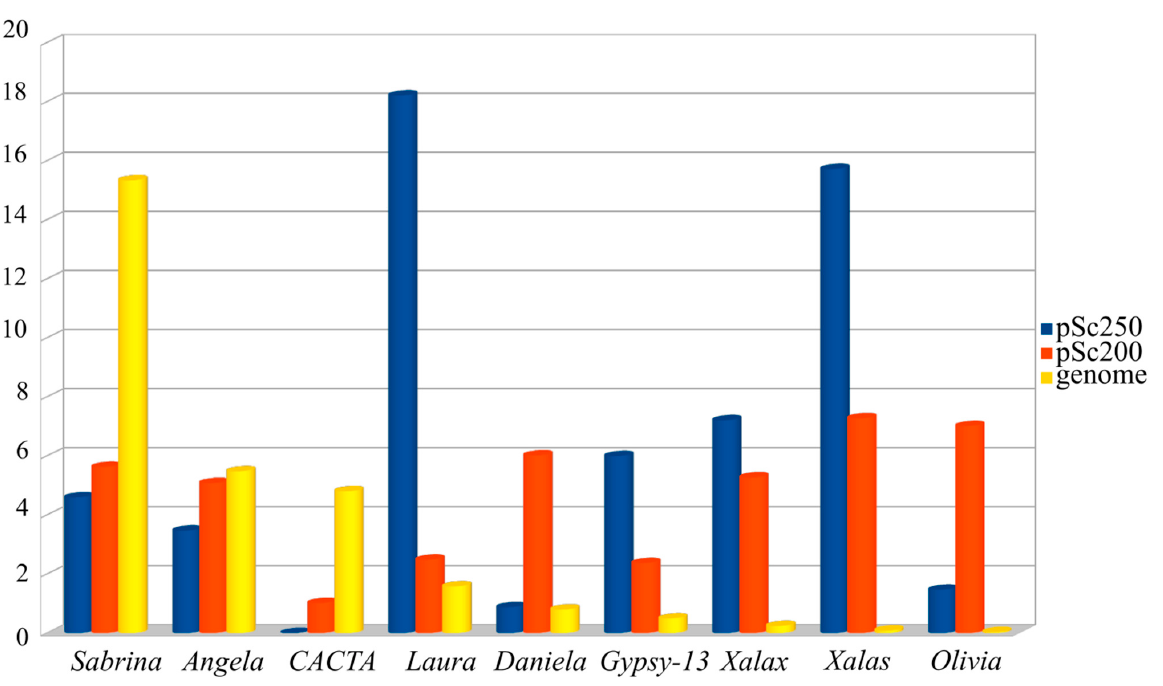
Figure 2. Presence of the most well-represented TE families in the rye genome ( Sabrina, Angela, CACTA , yellow bars) and in the reads containing regions of junctions between non-tandem DNA and the monomers of pSc200 tandem repeats ( Olivia, Daniela, Xalas, Xalax, red bars) and pSc250 tandem repeats ( Laura, Xalas, Xalax, Gypsy-13_TA-I , blue bars). Thus, a surprising feature revealed by comparing the abundance of the DNA se- quences in the entire rye genome and when these sequences were flanked by the arrays of the tandem monomers pSc200 and pSc250 was a nearly reciprocal replacement of TE families. In terms of genome-wide abundance, Sabrina , CACTA and WHAM yield prece- dence to Daniela and Olivia flanked by pSc200 and Laura and Gypsy -13_TA-I flanked by pSc250, but the abundance of solo-LTRs designated as Xalas or Xalax is just rocketing, especially when these are flanked by pSc250. As the ectopic exchange model suggests [42], this should be indicative of very frequent ectopic exchanges in the immediate neighborhood of the tandem arrays pSc200 and pSc250 while these arrays were in the making. The main sources of solo-LTRs are probably unequal cross-overs and the with- in-chromosome ectopic recombination between the LTRs of the same or different ele- ments, provided that they share quite extended homologous regions, such as those shared by Xalas and Xalax , and Daniela and Olivia . Vicient et al. [43] distinguish four forms of retrotransposon recombination. One of these forms is the LTR-LTR recombina- tion, which results in solo-LTRs or tandem arrays consisting of LTRs and internal do- mains. According to this mechanism, if an LTR borders with any other DNA sequence, for example, pSc200 or pSc250 monomers, then the LTR-LTR recombination will generate a tandem array of these monomers next to the LTR.